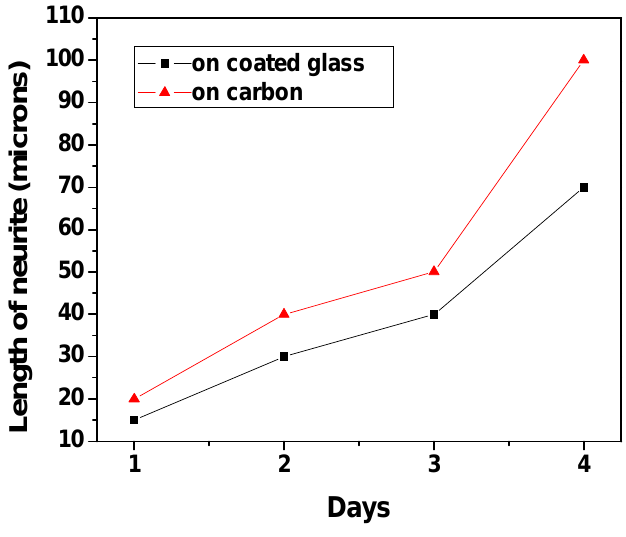
Figure 6. Length of Neurite as a function of